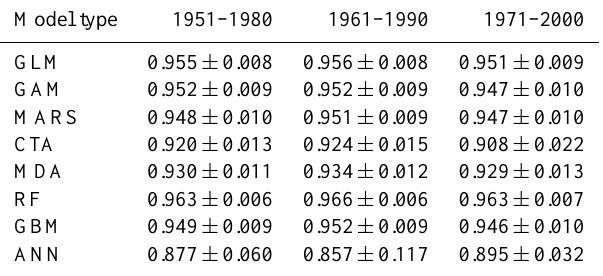
Table 3. Mean and standard deviation of the AUC evaluation statis- tics of the 25-member ensemble of palsa models for three calibra- tion time